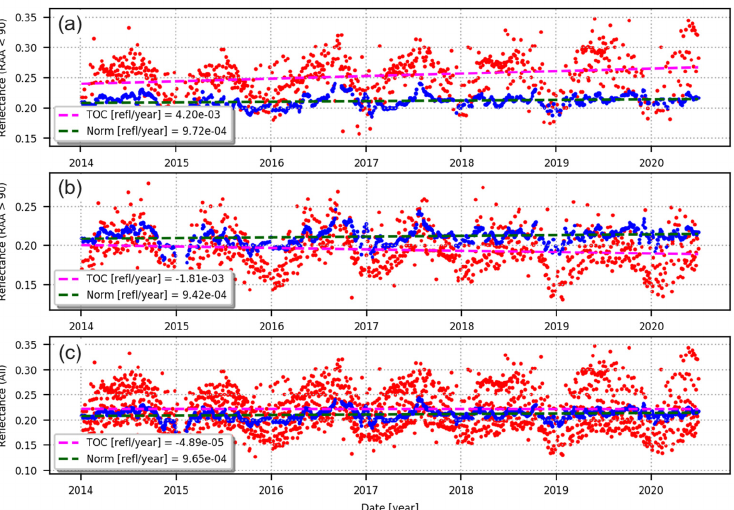
Figure 9. The figure shows TOC reflectance in NIR band for a shrubland site (Belmanip-57) located in the north of Mexico (lat/lon = 27.57°/ − 103.61°). The plots present the temporal series of TOC (red) and BRDF-normalized (blue) reflectances for three angular conditions: ( a ): RAA < 90°, ( b ) RAA > 90°, ( c ): “All”; the latter corresponds to retaining all observations in the fit. The fitted linear curves are also shown for TOC (purple) and BRDF-normalized (green) data with drift values reported in the legend.